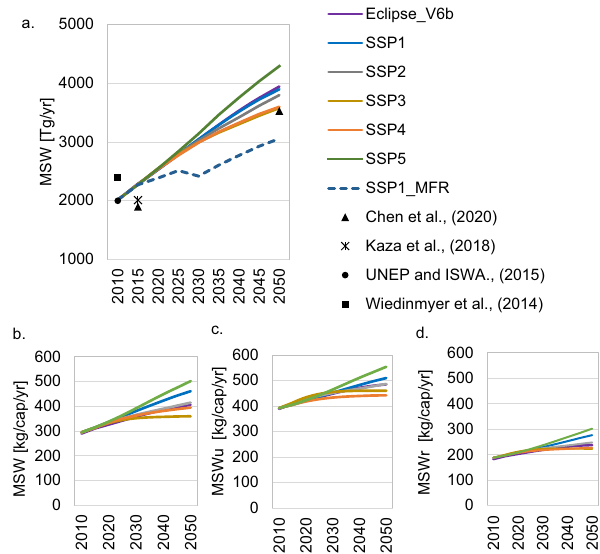
Fig. 1 Global total and per capita municipal solid waste